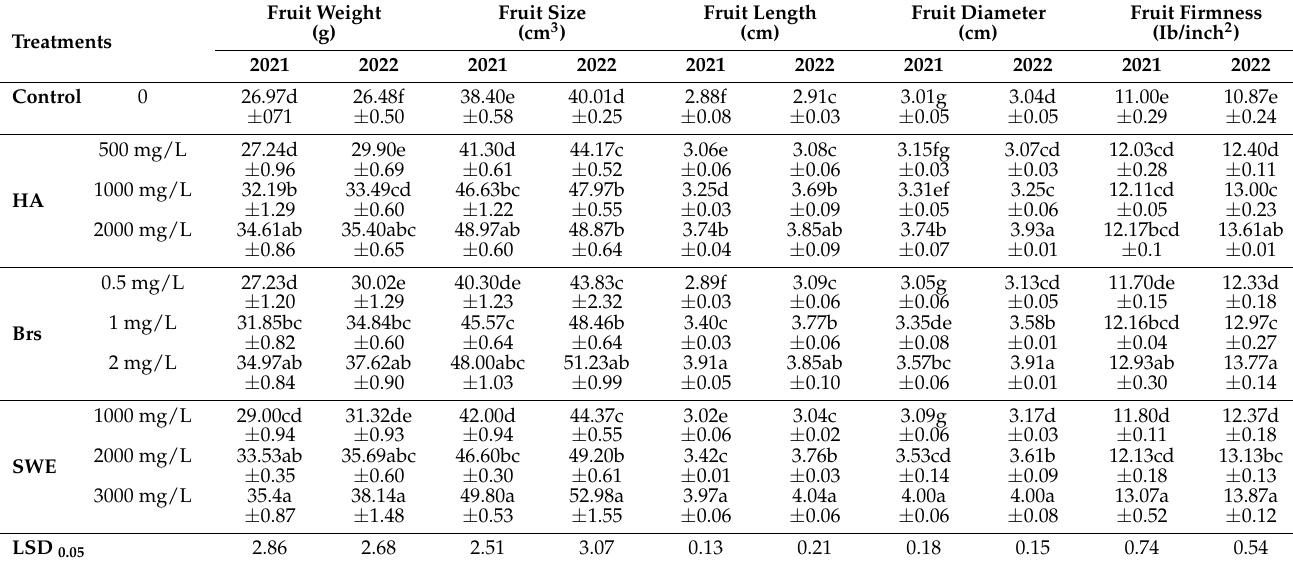
Table 6. Effect of foliar spraying of HA, Brs, and SWE on the fruit weight, size, length, diameter, and firmness of apricot cv. Canino during 2021–2022.